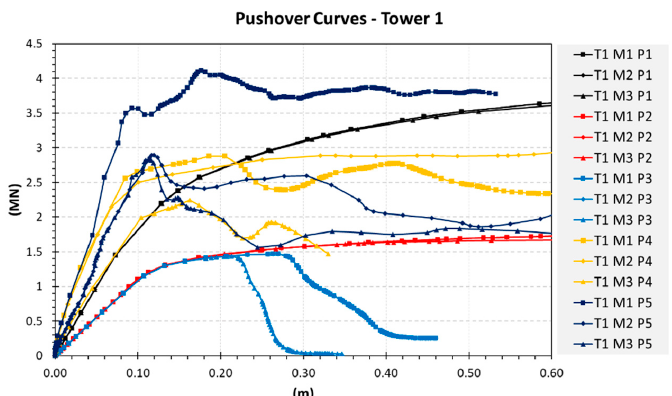
Figure A1. Pushover curves results for the case of Tower 1.